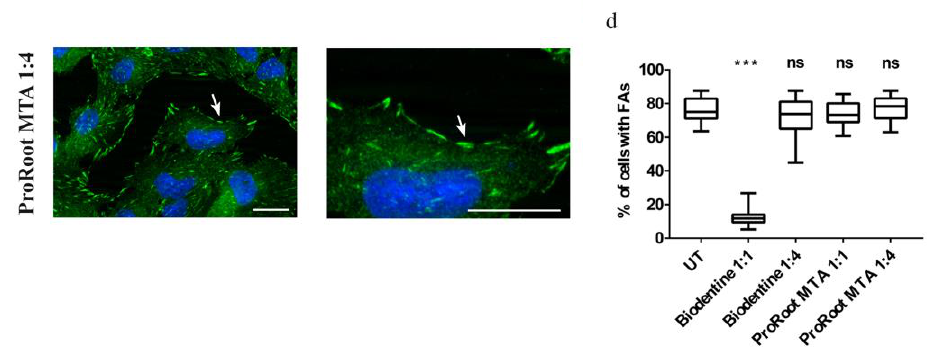
Figure 5. Focal adhesions (FAs) in cells. ( a ) Immunofluorescence analysis performed on Saos-2 cells labelled with anti-FAK antibodies (green) and DAPI (blue) to stain nuclei, after 72 h of treatment with Biodentine or ProRoot MTA extracts at different dilutions. Arrows indicate FAs. UT: untreated sample. Scale bars represent 10 µ m. ( b ) Length of FAs, ( c ) Average number of FAs per cell and ( d ) percentage of cells with FAs. Box-and-whisker plots represent standard values (minimum, first quartile, median, third quartile, and maximum). Asterisks represent significant differences. Statistical analysis was performed by one-way analysis of variance (ANOVA) method coupled with the Bonferroni post-test (*** p < 0.001, * p <0.05) compared to the untreated sample (UT); ns: not significant).